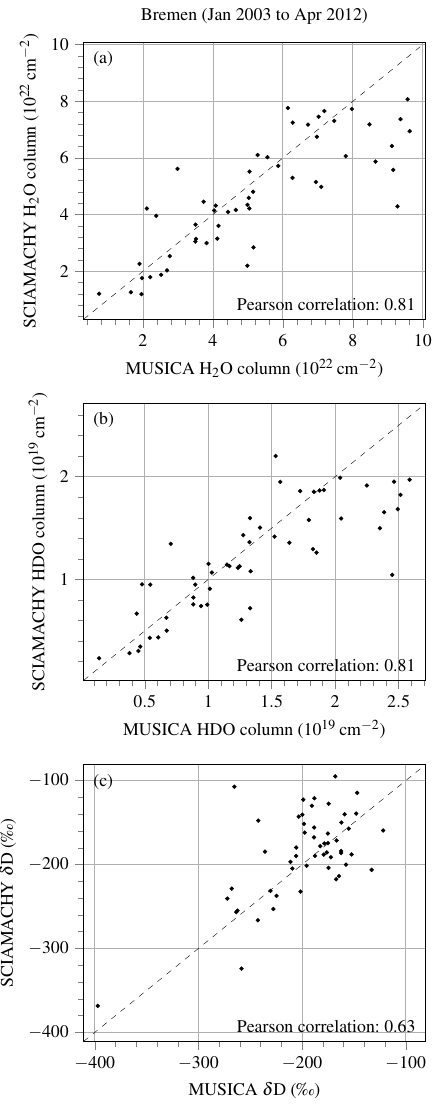
Figure 4. Correlation plots for monthly medians of MUSICA and SCIAMACHY observations of H 2 O (a) , HDO (b) and δ D (c) at the station Bremen between January 2003 and April